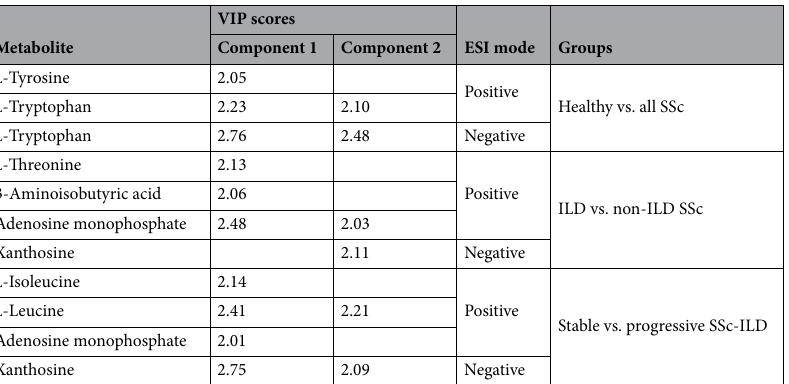
Table 2. Significant VIP scores from PLS-DA for all group comparisons by electrospray ionization (ESI) mode and x-variate component. Significance is defined by VIP values ≥ 2 meaning that these metabolites were essential for the discrimination of different groups of patients in PLS-DA 14,21 .